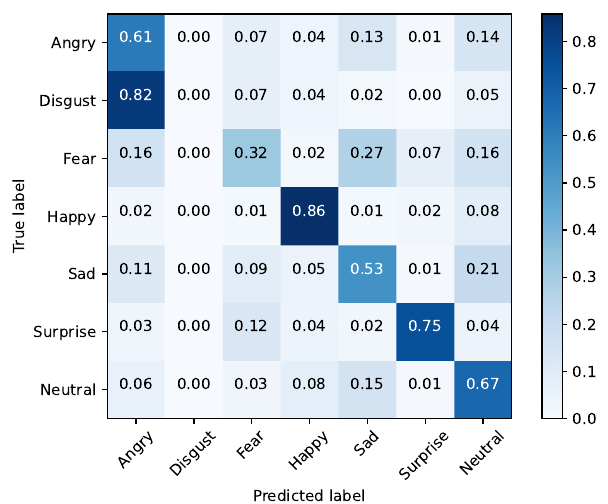
Figure 5. Inceptionv3—training set